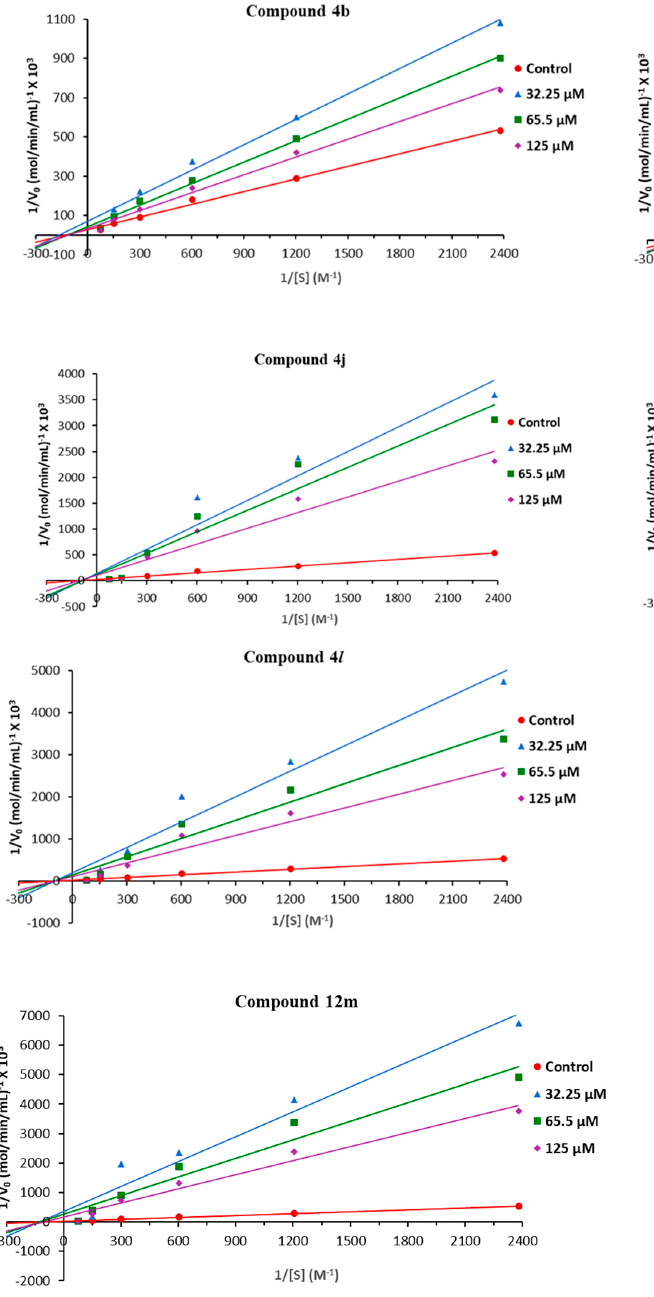
Figure 4. Lineweaver–Burk plots of promising α -glucosidase inhibitors.